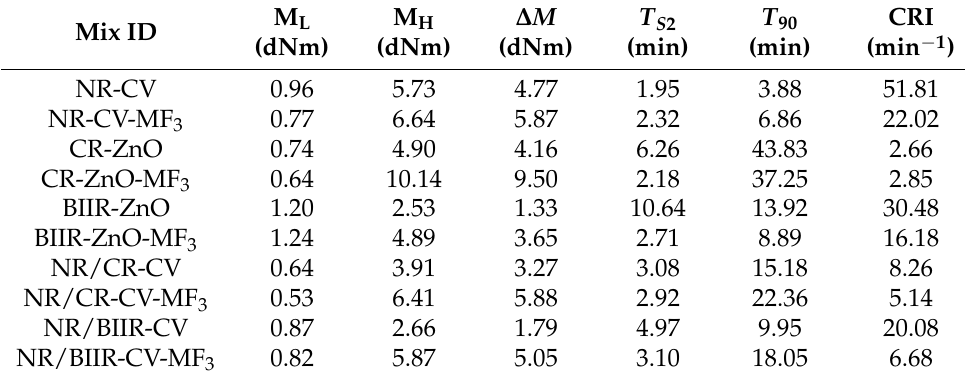
Table 2. Cure characteristics of the mixes at 170 ◦ C, 1 h.